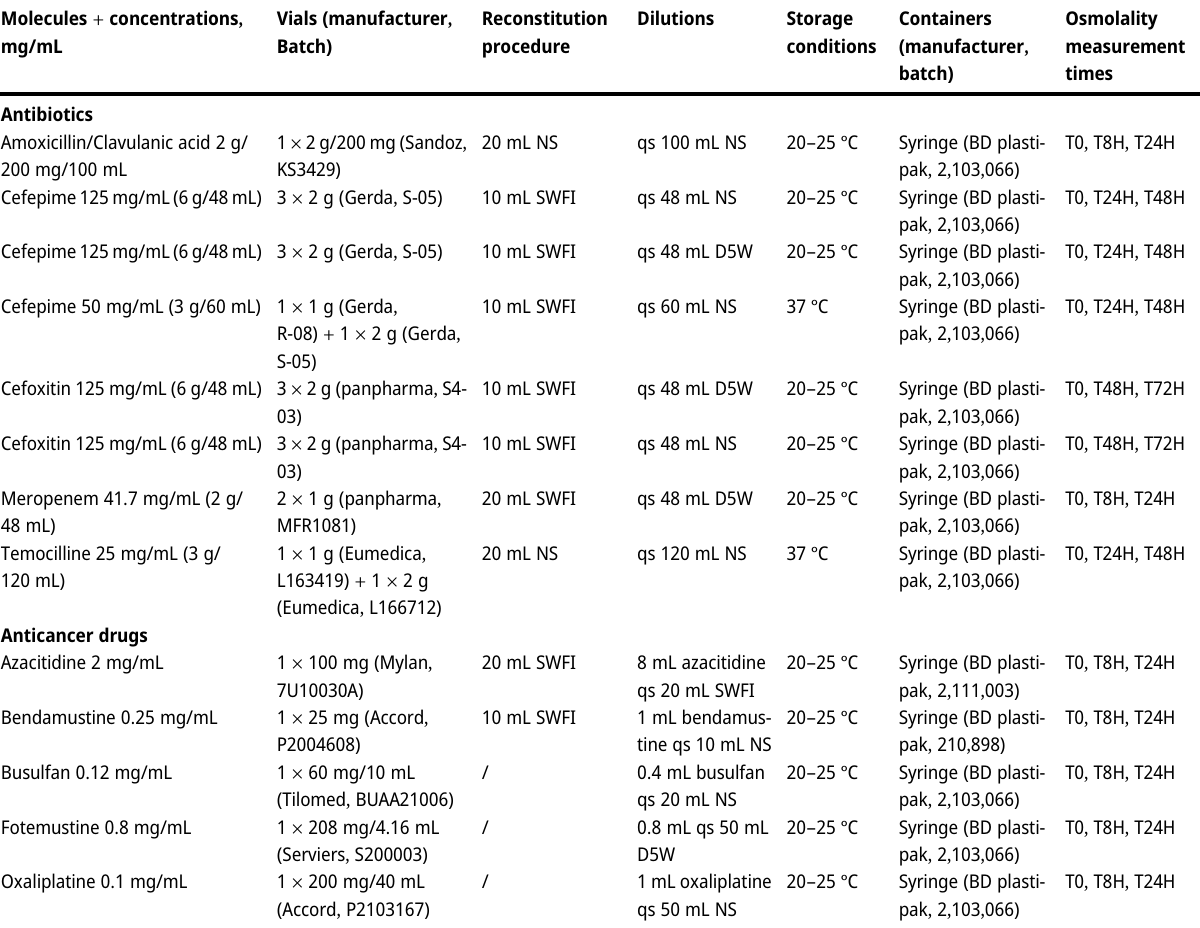
Table  : Mode of preparation of selected samples. Molecules +